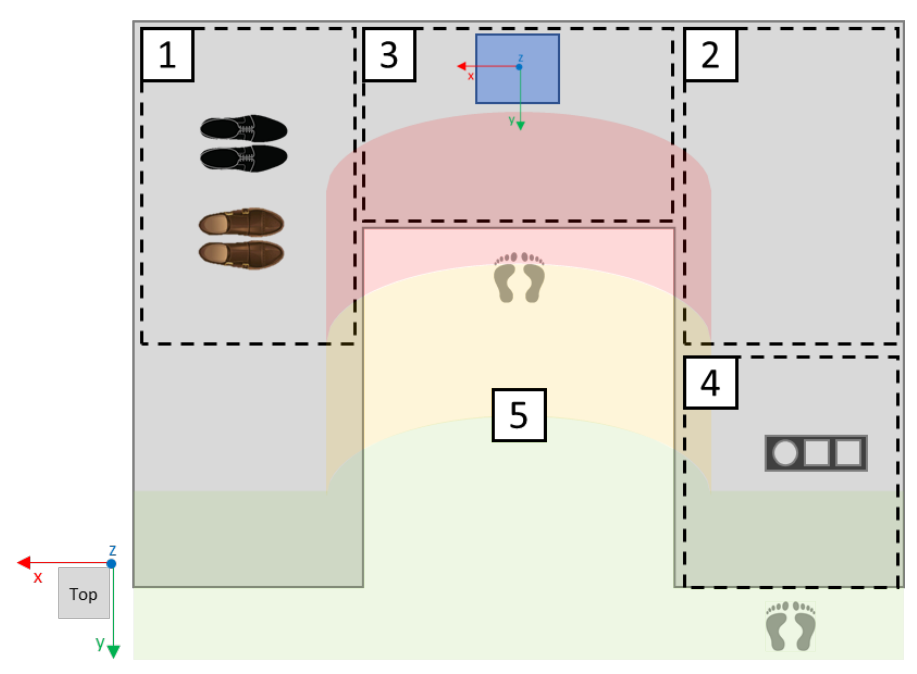
Figure 5. Workstation zones.